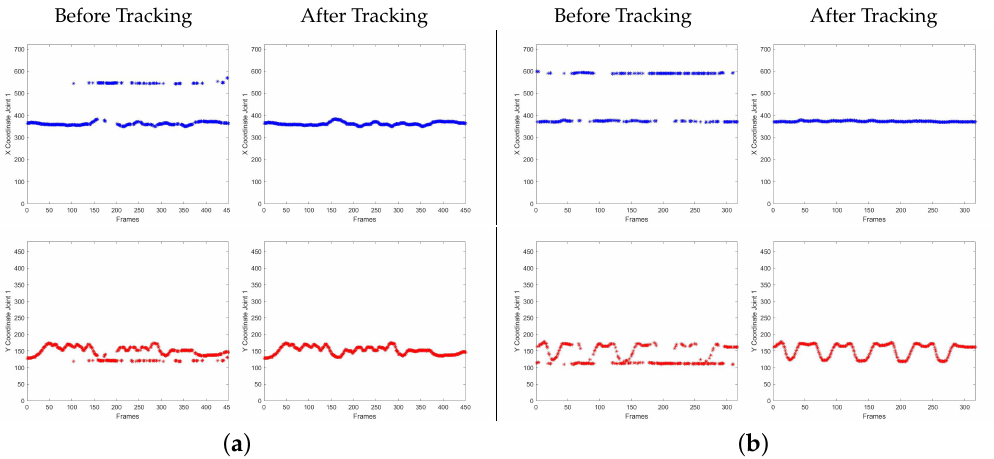
Figure 4. Plots of x and y coordinate of nose joint (joint 1) before and after applying the tracking procedure, in the case of a sick patient ( a ) and healthy subject ( b ),